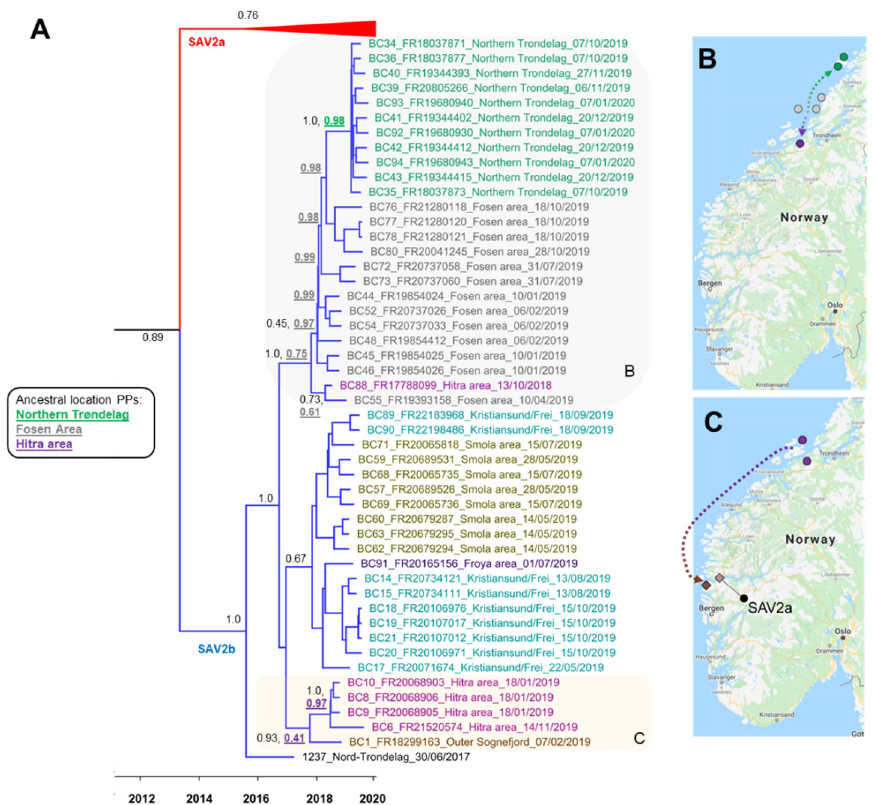
Figure 6. ( A ) Time-calibrated Bayesian phylogeny (Figure 4), focussing on the SAV2b clade, including results of the phylogeographic model. Tip names are colored according to the region of sample origin. PP values for key nodes are shown in black font. PP values for the ancestral location of samples are shown at relevant nodes, using font colors matching the given key for different aquaculture regions. ( B ) Inferred scenario of SAV2a spread from the Fosen area to Northern Trøndelag. ( C ) Inferred scenario of SAV2a spread from the Hitra area to Outer Sognefjord.